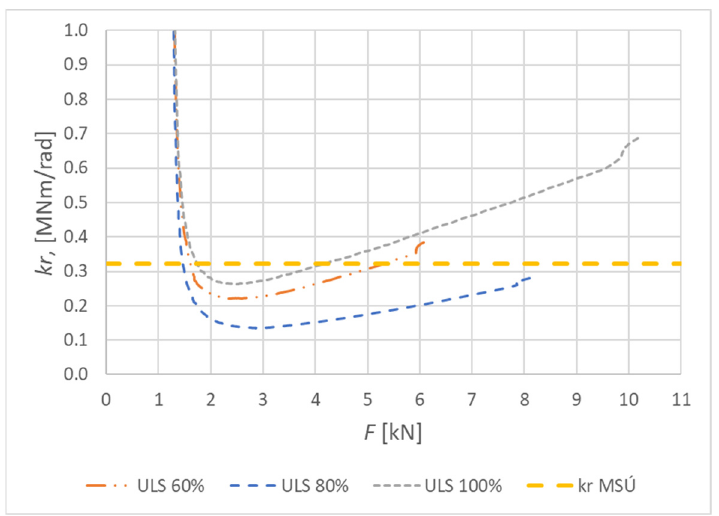
Figure 20. Course of rotational stiffness of a semirigid connection for specimens made from fully threaded screws (Experiment B).